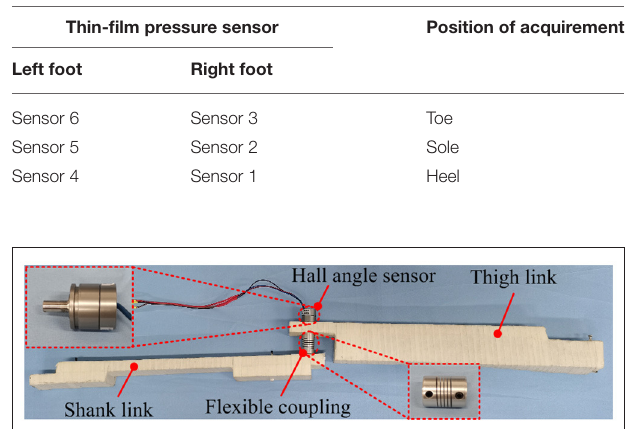
FIGURE 3 | A knee joint angle acquisition